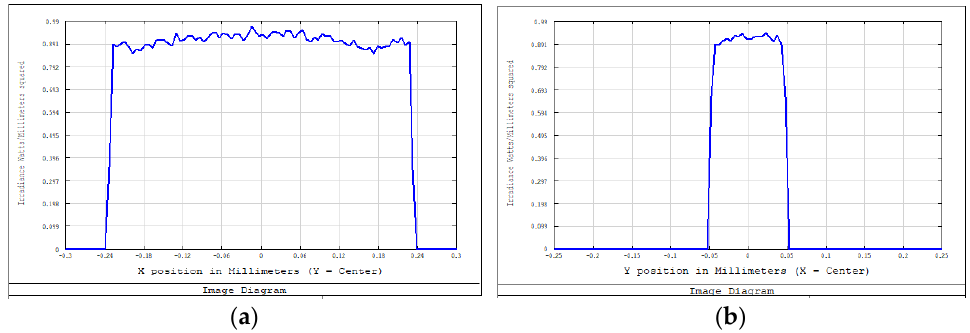
Figure 13. Light-field-intensity distribution of the focusing system with a working distance of 535 mm. ( a ) Light-field-intensity distribution in the X-direction. ( b ) Light-field-intensity distribution in the Y-direction.